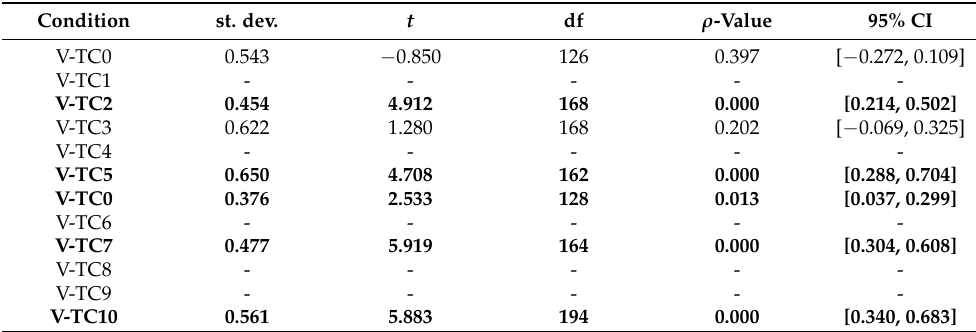
Figure 11. Average MQS values for different video test conditions in Experiments 1 and 3. Table 12. Two-sample t -test analysis between equivalent conditions from Experiment 1 and Exper- iment 3 (st. dev.: Standard deviation, t : Test statistic, df: Degrees of freedom). Conditions with statistically significant differences are